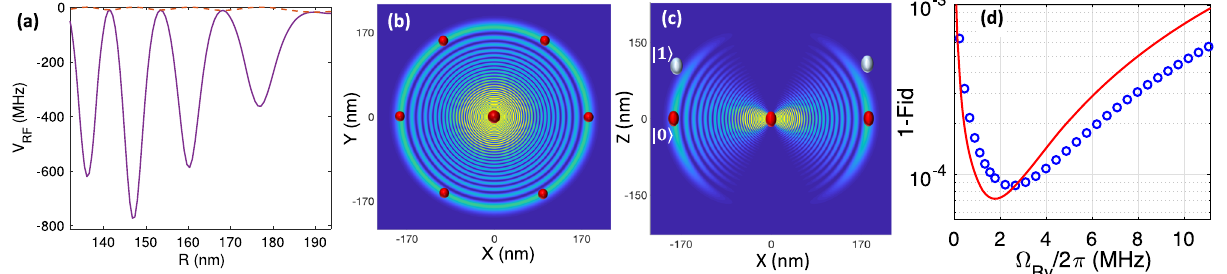
Fig. 7 Interaction enhancement by resonance scattering in Cs atoms. a PEC with S- and P-wave scattering in Cs atoms. The coupling of the Rydberg state ; 5 = 2 i with the neighboring states 43 H þ 42 H þ 47 P þ 48 S j i is considered under Eq. (12). Interaction strength is plotted across the radial direction j 46 D 5 = 2 from the Cs + core with θ = π /2 in spherical coordinates. The solid line and dashed line show the total and exclusive s-wave scattering respectively. b , c The ; 5 = 2 i Rydberg wave-function along b xy and c xz are plotted. The red and white circles depict the con fi ning area of the 0 j i and 1 j i cross-sections of j 46 D 5 = 2 qubit states of a plaquette lattice site, while the Cs + core is at the origin. d The in fi delity of C 6 -NOT operation as a function of Rydberg exciting Rabi- frequency. The solid line is based on the analytic model for a square laser pulse while the circles are based on the numerical simulation of Eq. (9), obtained R T Ω ð t Þ d t ¼ 2 π . The fi delity quanti fi ed by Eq. (10), for a Gaussian pulse Ω r exp ð(cid:2) ð t (cid:2) T = 2 Þ 2 Þ exp ð(cid:2) ð T = 2 Þ 2 Þ with σ = T /5 and a pulse duration T given by 0 2 σ 2 2 σ 2 encounters spontaneous emission and rotation approach are discussed in 44,116 . Considering the Gaussian ground motional state with a half-width at 1/e maximum of σ x , y = 8.7 nm, the atom would accommodate within a single lobe of V RF , see Fig. 7b, c. For spin-dependent trap perpendicular to the plane (along the z ) the λ = 870 nm laser could be used for dressing 6 S j i to 6 P j i , with U /2 π = 2 MHz, σ z = 20 nm, D z = 100 nm. Exciting the target atom to ; 5 = 2 i , the Rydberg-Fermi interaction averaged over the l th plaquette atom ’ s j 46 D 5 = 2 wave-function in the ground motional state would be (cid:1) V ¼ 365MHz ; MD ¼ 0 : 07MHz V RF1 l j i RF 1 l j i (cid:1) ð 15 Þ see Eq. (2) for the de fi nitions. This contrast of spin-dependent level-shift with narrow lines allows fast selective laser excitation of the central atom conditioned on the plaquette qubits ’ con fi gurations. This would result in high fi delity operation of C 6 -NOT gate as depicted in Fig. 7d. The fi delity is quanti fi ed along the same lines described in Fig. 4. Qubit-Rotation in the spin-dependent lattice . A spin-dependent lattice provides dual spin/spatial encoding of the qubit. A Raman transition coherently transfers an atom from one internal state to the other, thereby causing hopping between the two Wannier-functions 76 – 78 , see Fig. 8d. The polarizability of the qubit states 0 j i , 1 j i and